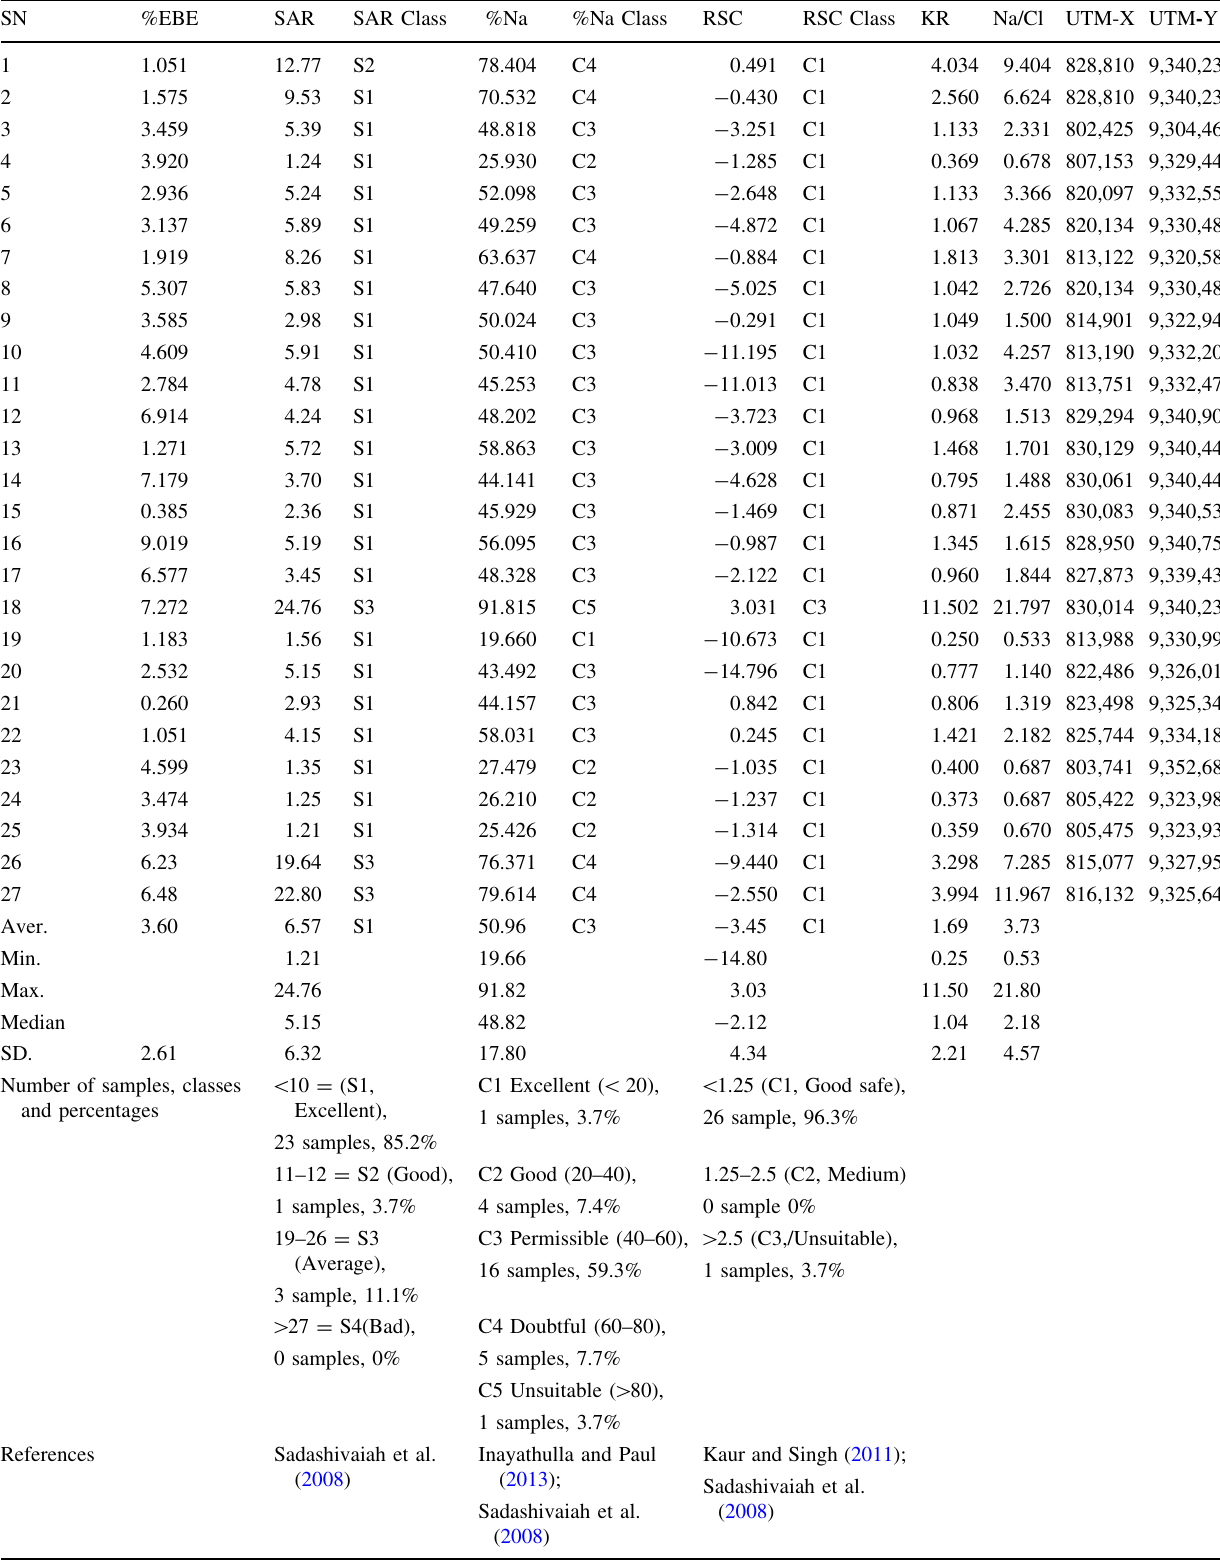
Table 2 Major statistics for SAR, %Na, RSC, KR and